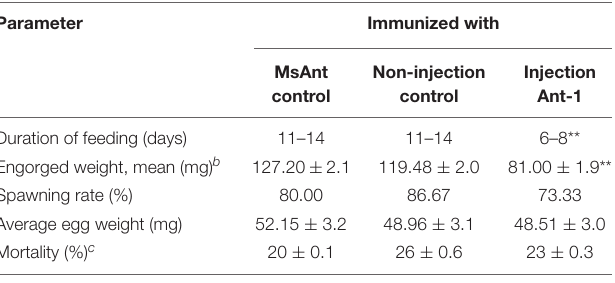
TABLE 5 | Effect of vaccination with miR-1 inhibitor on tick feeding a .